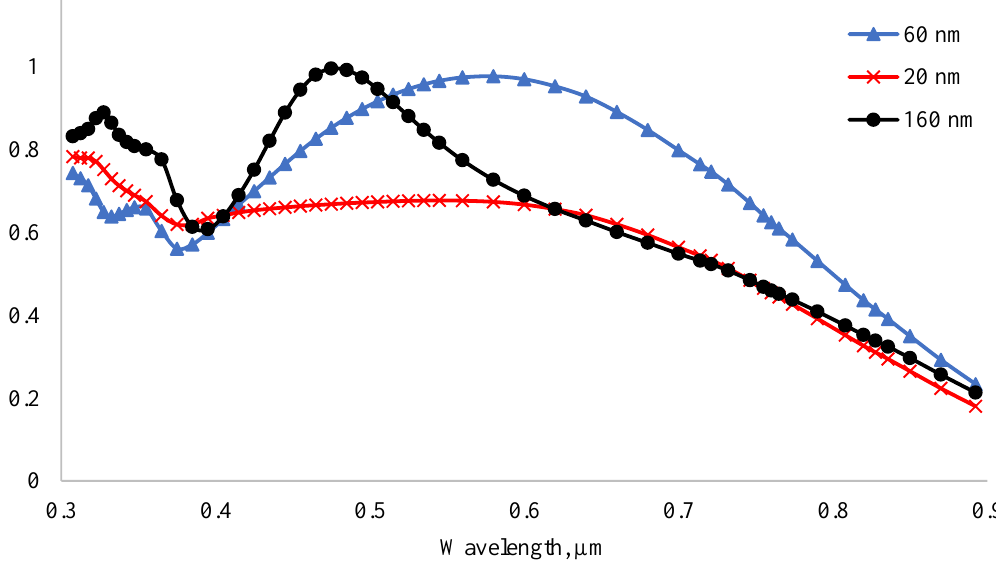
Figure 10. Absorption coefficient of MoO 3 /Si heterojunction solar cells.